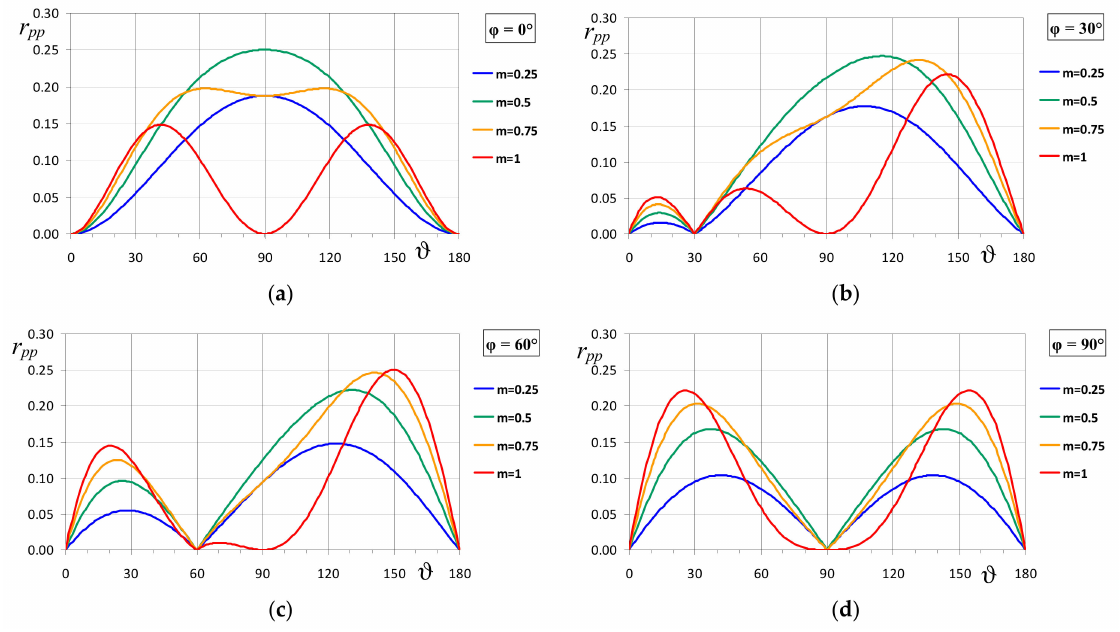
Figure 5. Normalized peak-to-peak DC-link voltage ripple amplitude r pp ( ϑ ) in a half-fundamental period (0, 180 ◦ ) for different modulation indices, m = 0.25, 0.5, 0.75, and 1, and output phase angle ( a ) ϕ = 0 ◦ ; ( b ) ϕ = 30 ◦ ; ( c ) ϕ = 60 ◦ , and ( d ) ϕ = 90 ◦